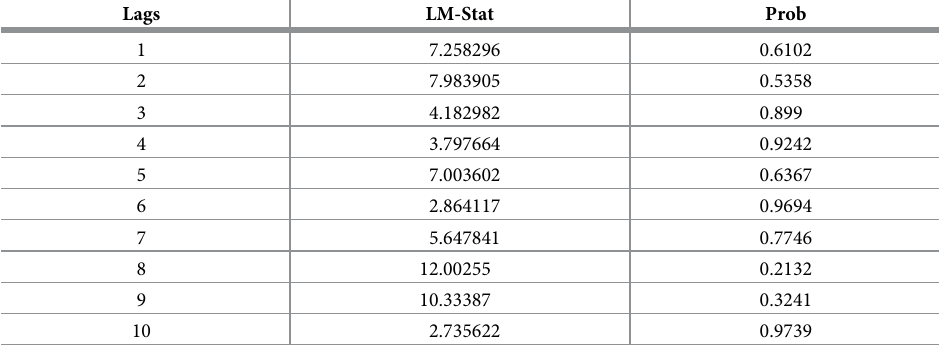
Table 9. Serial correlation LM test for Korean data when P = 1 (proposed